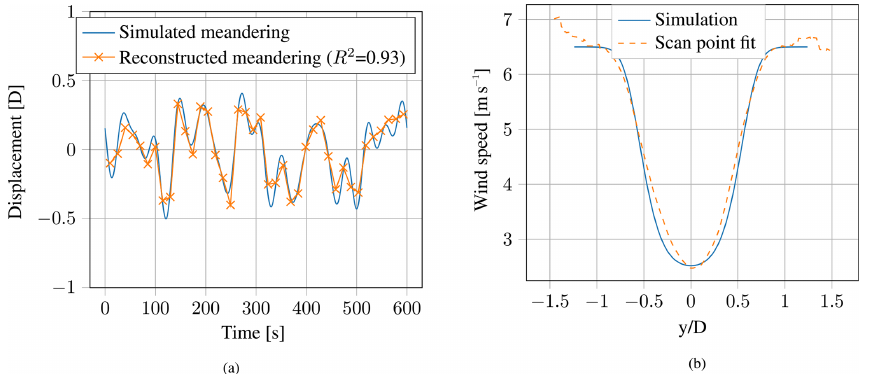
Figure 6. Simulated and simulated “measured” meandering time series (a) and wind speed deficit in the HMFR (b) at an ambient wind speed of 6.5ms − 1 .